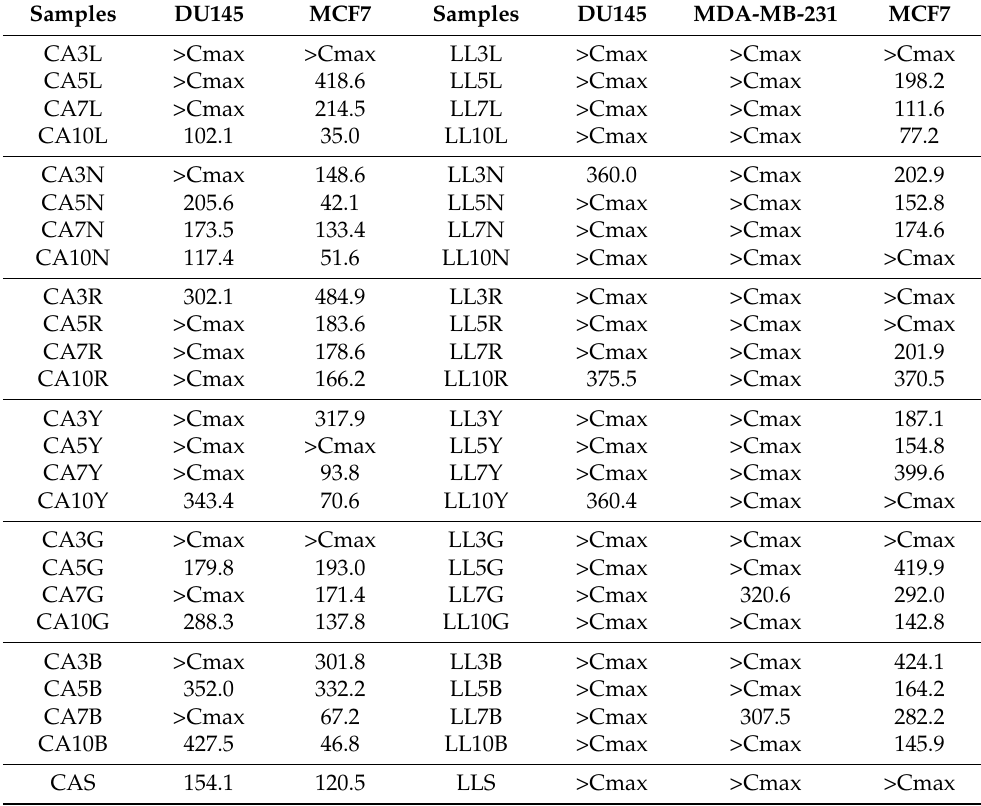
Table 3. Cytotoxic activity of the chickpea (CA) and lupin (LL) seeds and sprouts harvested for 3, 5, 7, and 10 days on prostate cancer (DU145) and breast cancer (MDA-MB-231, MCF7) cells, expressed as IC 50 values ( µ